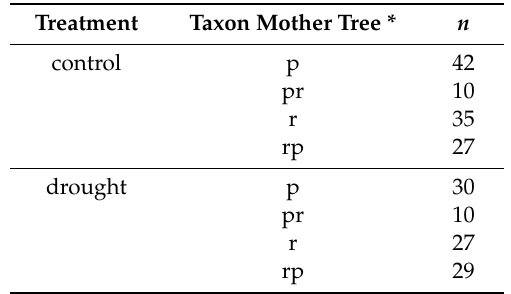
Table 1. Number of oak seedlings (n) according to the drought treatment in 2014 and the taxon of the mother